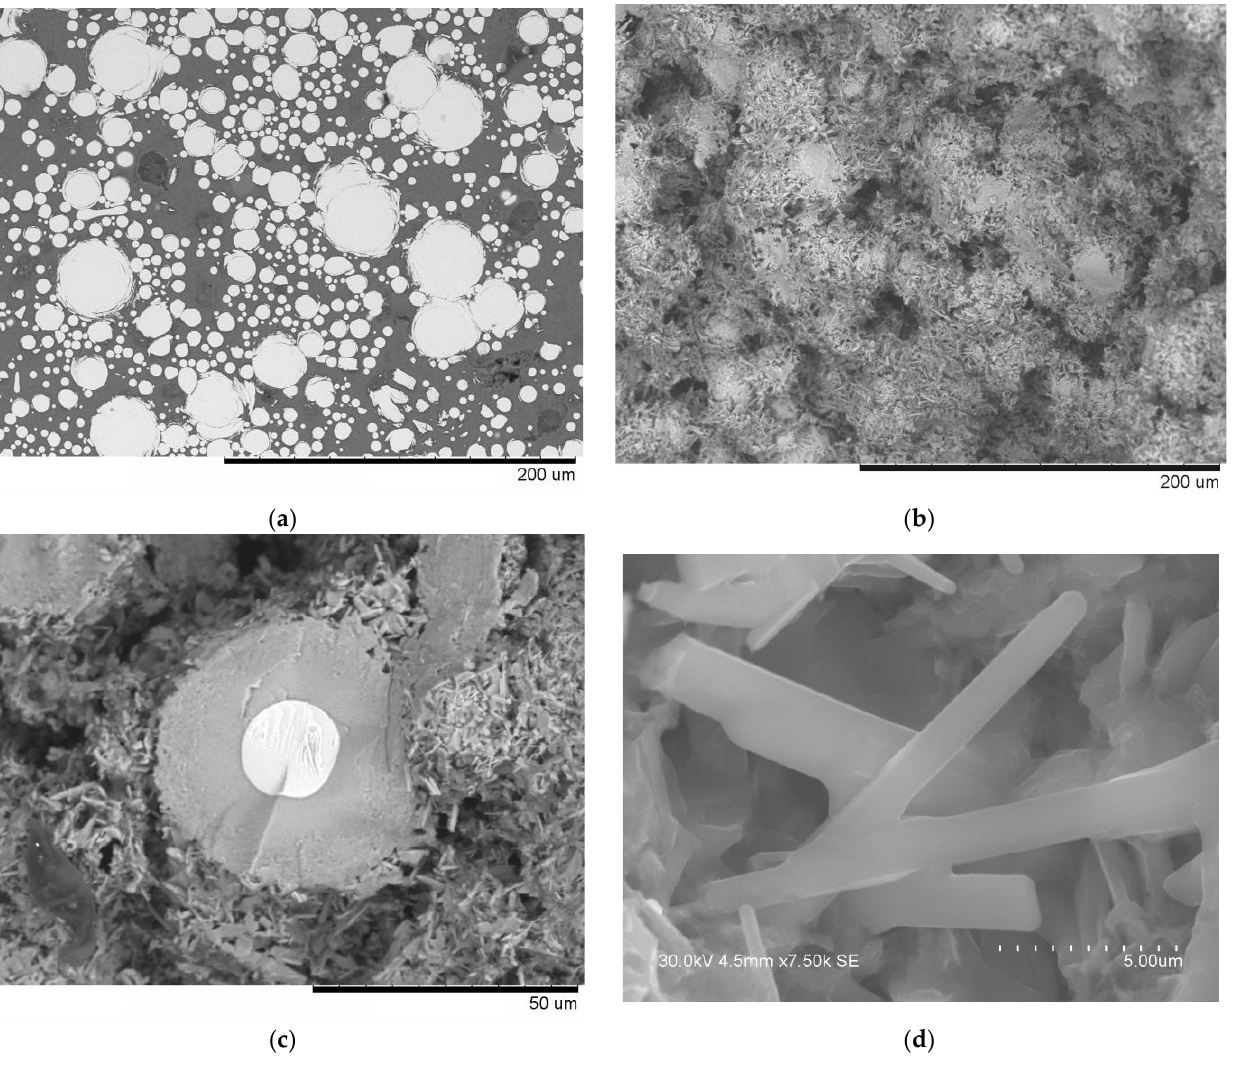
Figure 8. ( a ) Microstructure of the composite obtained by SPS of Al – 20 vol.% Fe 66 Cr 10 Nb 5 B 19 . Al powder 3 – 10 μm. SPS conditions: temperature— 500 °C, holding time — 3 min, applied pressure — 40 MPa. ( b ) Fracture surface of the composite obtained by SPS and further annealed at 620 °C for 2 h. ( c ) An area of the fracture surface showing an unreacted Fe-based alloy core surrounded by platelets and needles of the intermetallic products. ( d ) The product of interaction with needle morphology. ( a , b , c ) BSE images. ( d ) Secondary electron (SE) image.